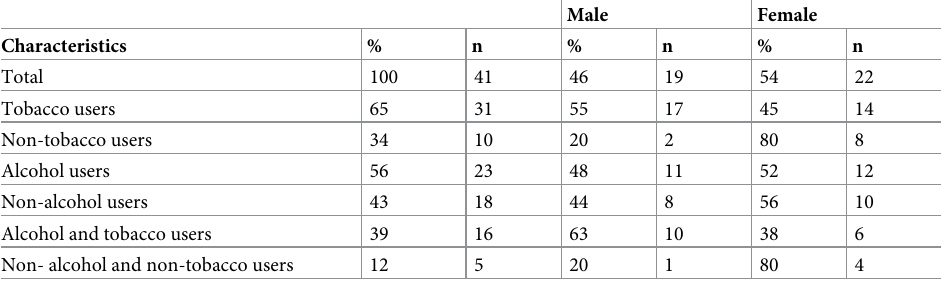
Table 1. Behavioural characteristics of the OSY